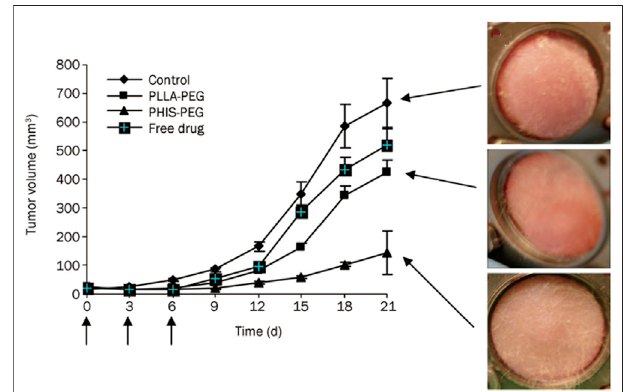
FIGURE 11 | Effects of DOX-loaded pH-sensitive PH-b-PEG micelles and pH-insensitive PLLA-b-PEG micelles on the growth of MDA 231 breast carcinoma in the window chamber model (Jin et al., 2014). Each formulation was administered three times at 3-day intervals (arrows) at a dose of 10 mg/kg for tumor growth inhibition study. Abbreviation: PEG, poly (ethylene glycol); PH, poly(L-histidine); PLLA, poly(L-lactic acid).